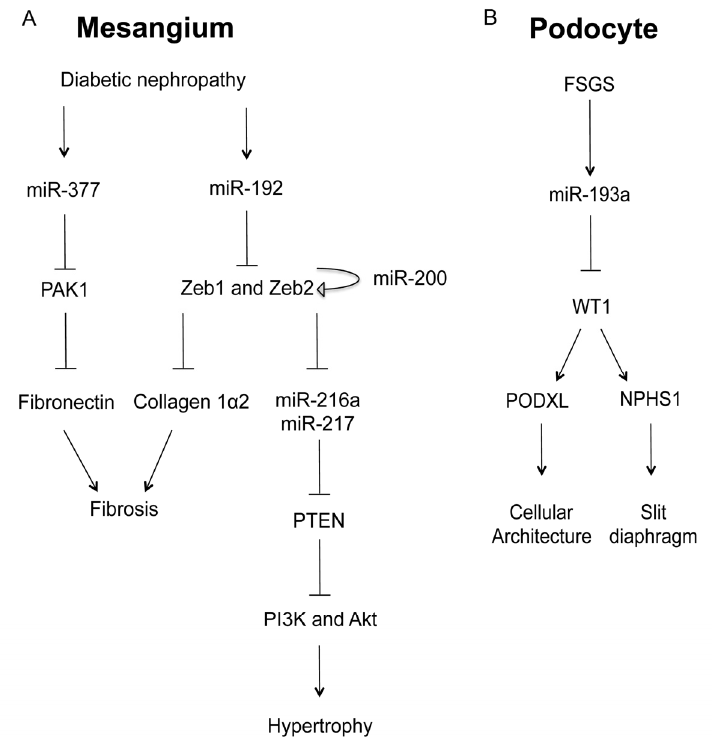
Figure 2. The role of microRNA in glomerular diseases. ( A ) In the mesangial cell, diabetic conditions increases the levels of miR-377 and miR-192, both of which promote fibrosis and hypertrophy through the signaling cascades involving PAK1 and Zeb1/2; ( B ) In the podocyte, focal segmental glomerulosclerosis (FSGS) induces the expression of miR-193a, which in turn inhibits WT1, a master regulator of podocyte homeostasis through podocalyxin (PODXL) and nephrin